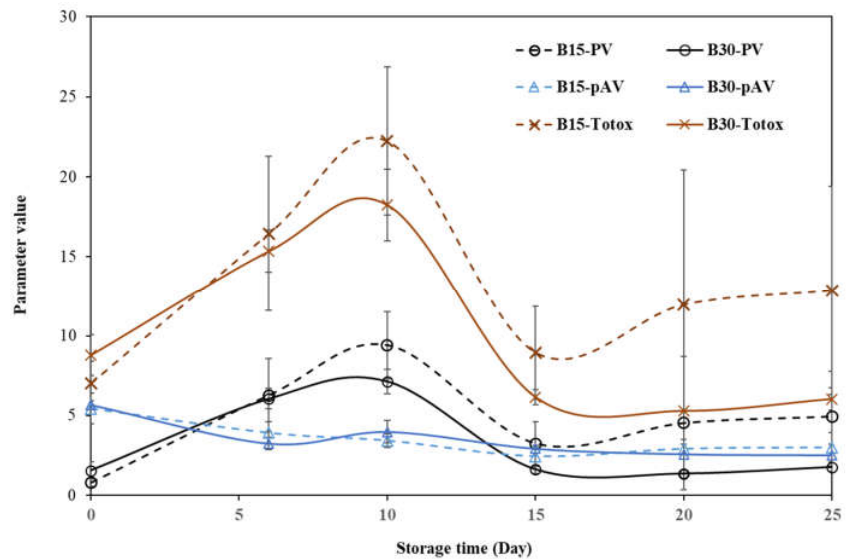
Figure 1. Changes in the oxidative stability values of cottonseed butters over the accelerated oxida- tion storage at 60 °C. B15 and B30, butter products made from the cottonseed roasted at 150 °C for 15 and 30 min, respectively. PV, peroxide value; pAV, p-anisidine value; Totox, total oxidation value. Data are present in the format of average ± standard deviation (n = 3). are present in the format of average ± standard deviation (n =